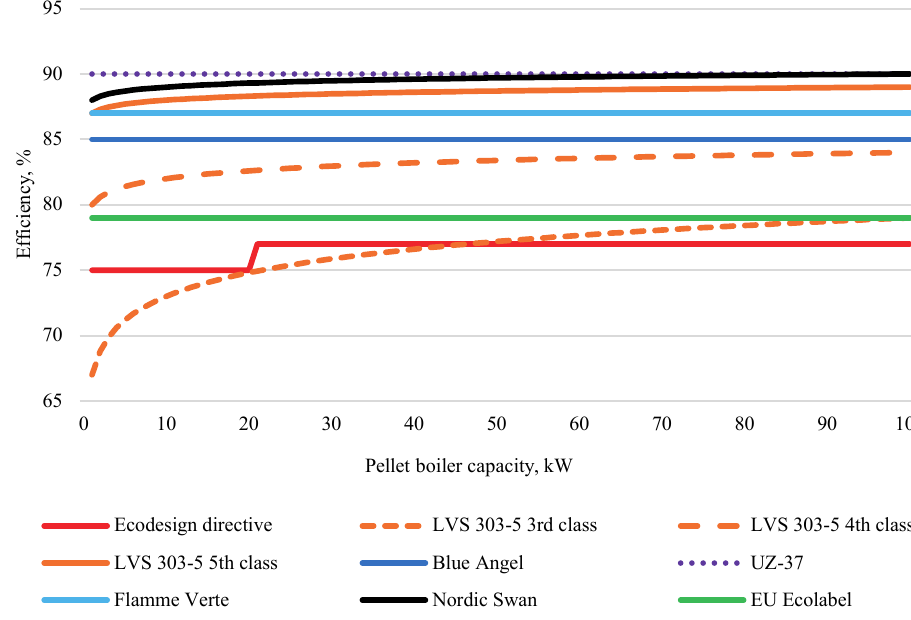
Fig. 2. Defined requirements regarding the efficiency of pellet